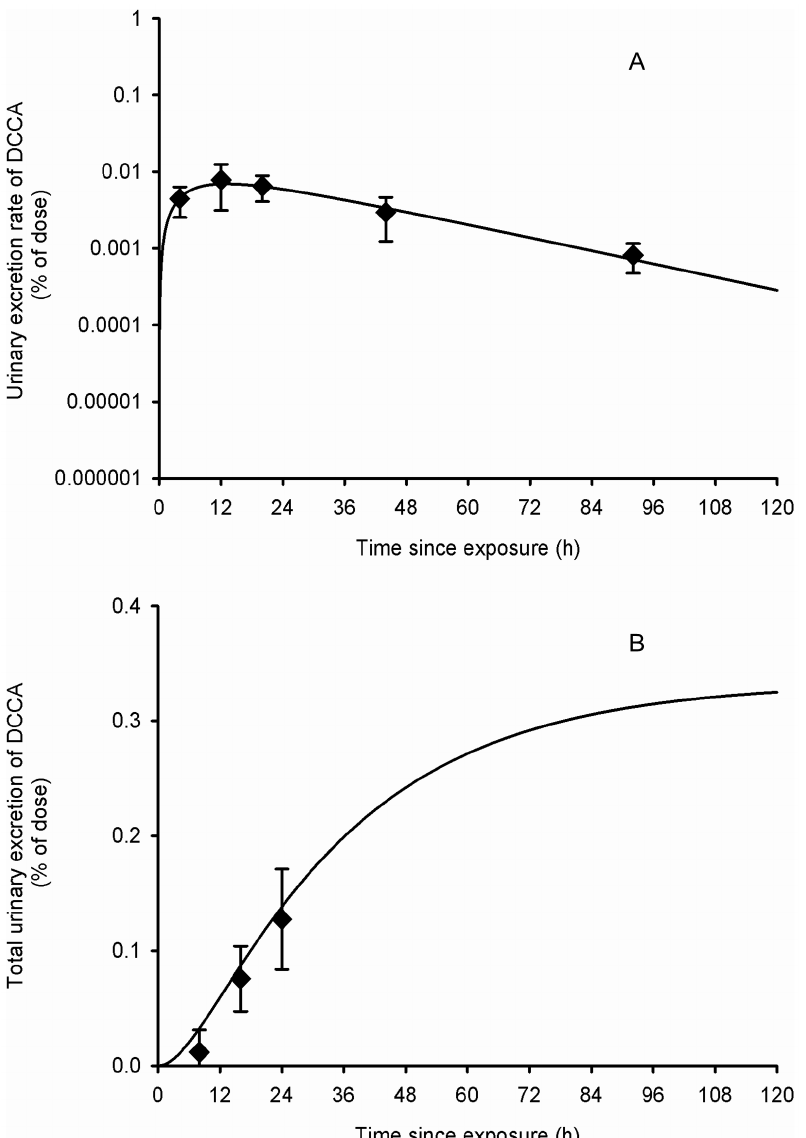
Figure 9. Comparison of model simulations with experimental data for DCCA (volunteers dermally exposed). Comparison of model simulations (lines) with experimental data of Tomalik-Scharte et al. (2005) (symbols) on the average time courses of DCCA excretion rate (A) and cumulative excretion (B) (% of applied dose) in healthy volunteers following a dermal application of 215 mg of a permethrin solution on the scalp. Diamond symbols represent average experimental values and vertical bars the experimental standard deviation